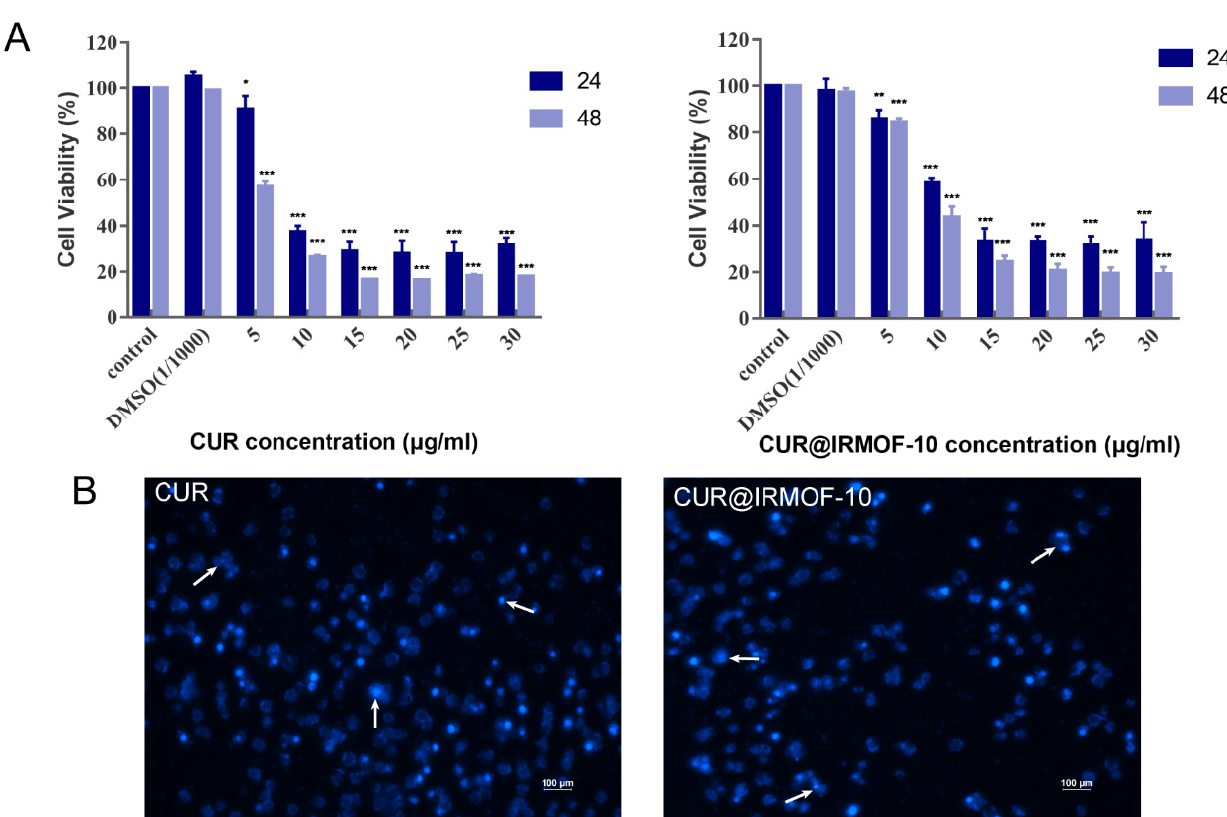
Figure 9. Toxicity of CUR and CUR@IRMOF-10 for HepG2 cells: ( A ) cell survival rate of HepG2 cells incubated with different concentrations of CUR and CUR@IRMOF-10 for 24 and 48 h—* p < 0.05, ** p < 0.01, and *** p < 0.001 vs. control; ( B ) fluorescence microscopic images of HepG2 cells stained with DAPI after 24 h treatment with CUR or CUR@IRMOF-10 (at IC 50 value).